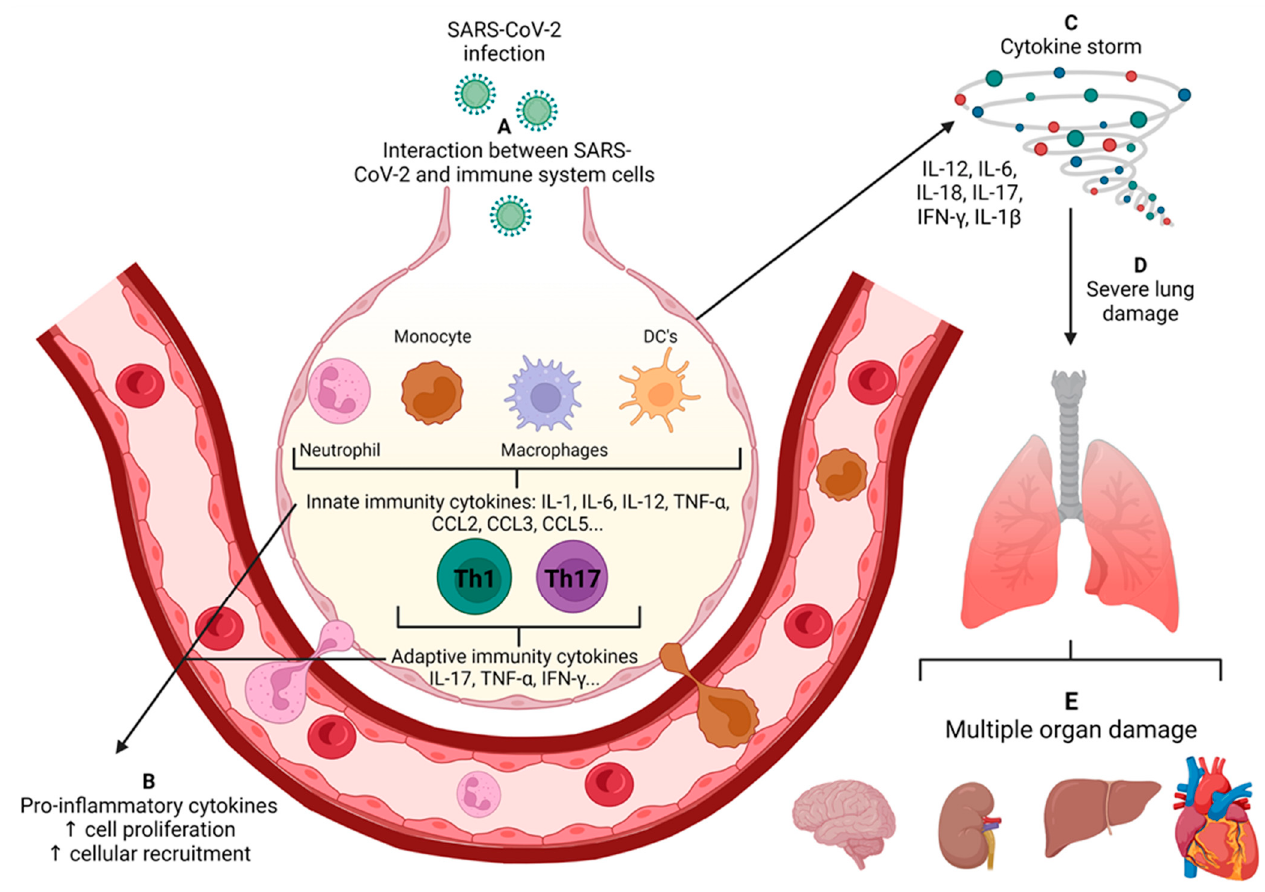
Figure 2. Development of systemic inflammation in the severe COVID-19. ( A ) After infecting lung epithelial cells, innate receptors distributed in the several lung immune cells recognize viral components and promote the secretion of several cytokines and chemokines. Such immune mediators act locally by promoting local inflammation and recruitment of inflammatory cells, such as neutrophils and monocytes, and by activating adaptive immunity. ( B ) Finally, in the severe forms of the disease, the overproduction of inflammatory mediators and lack of regulatory mechanisms favor the dissemination of the inflammatory process, which becomes systemic. ( C ) This process is called a cytokine storm, which drives the development of severe lung damage ( D ) and multiple organ dysfunction ( E ). Source : Created with Biorender.com.